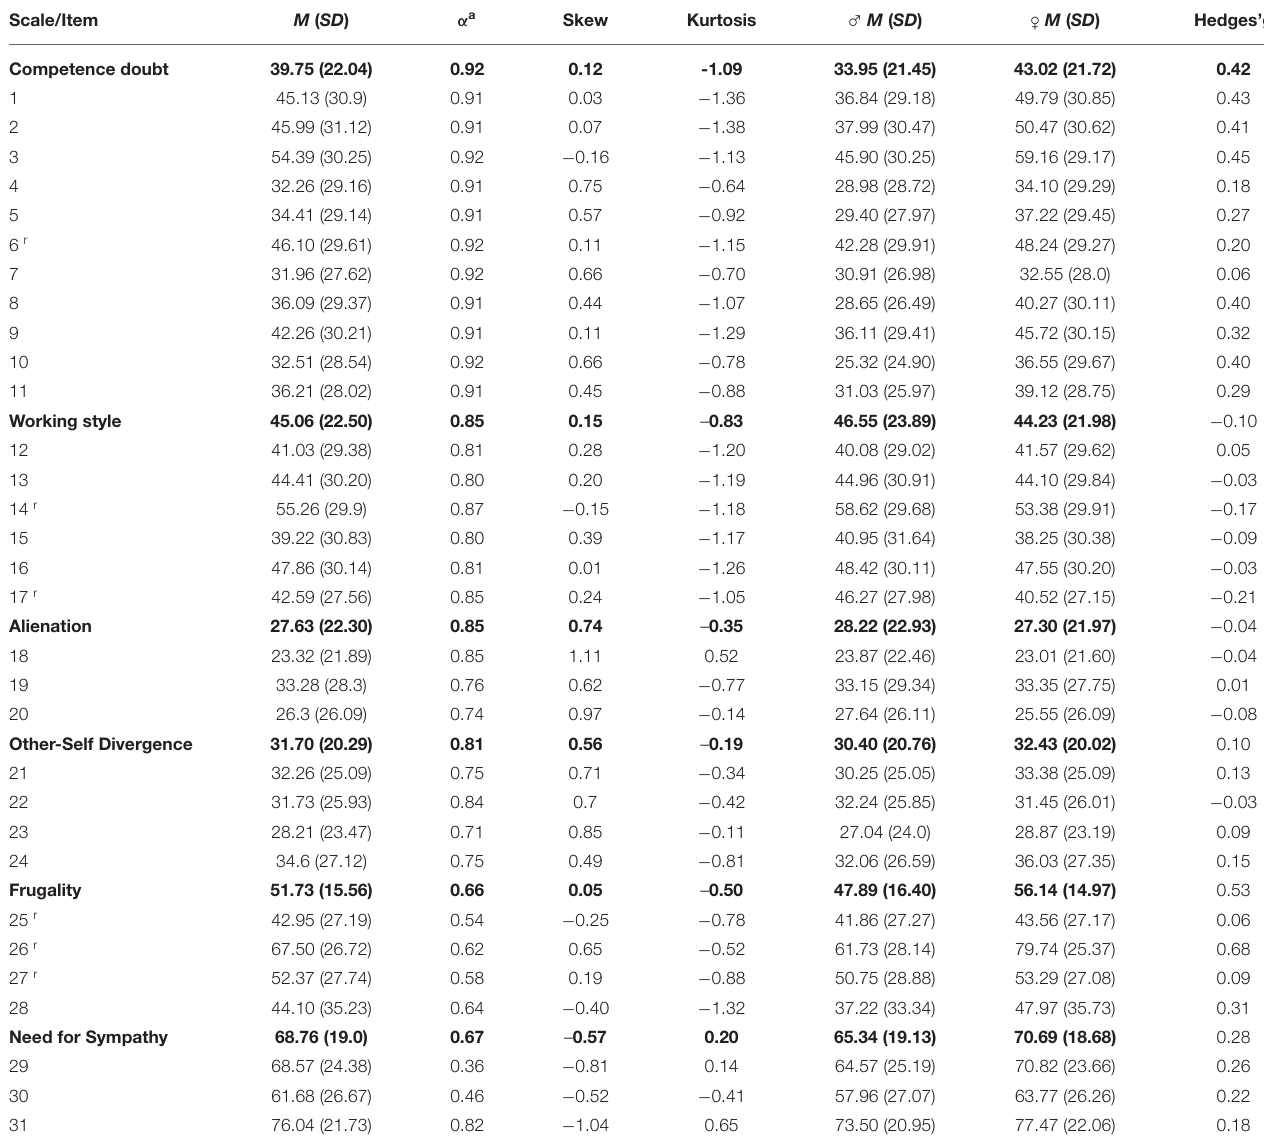
TABLE 1 | Descriptive statistics, internal consistencies, skewness and